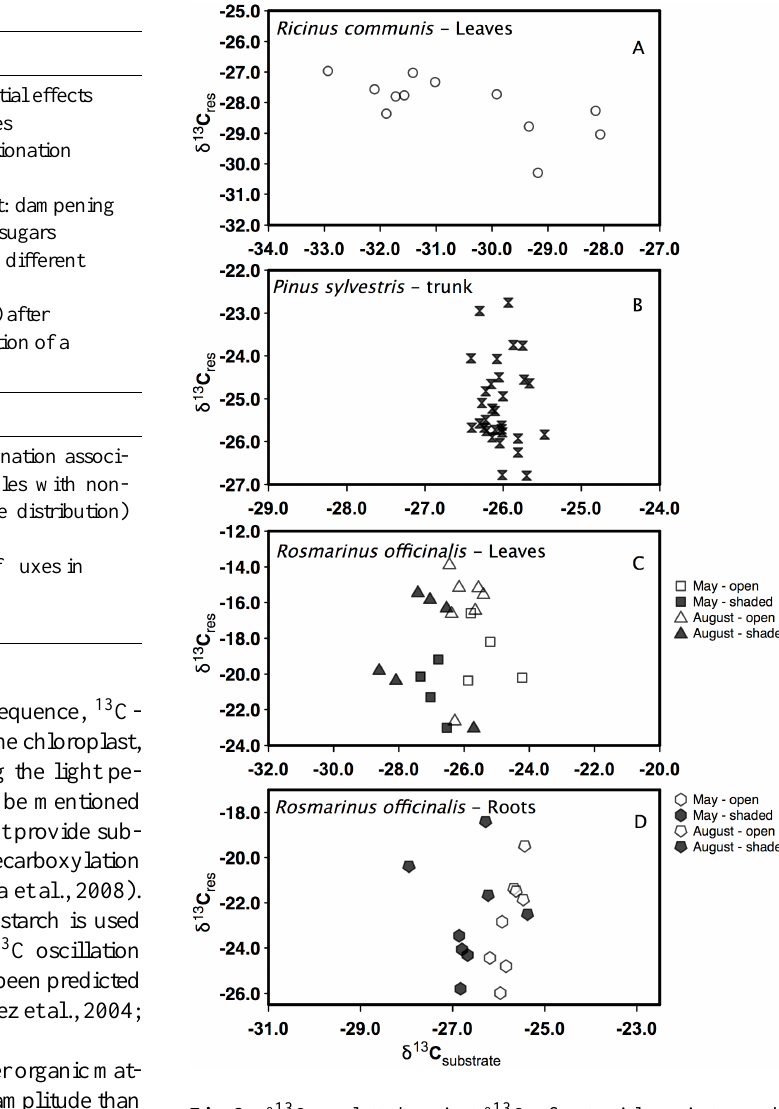
Fig. 3. δ 13 C res plotted against δ 13 C of potential respiratory sub- strates during the diel course. (A) data for leaf emitted CO 2 and leaf soluble sugars in R. communis during a 24h cycle. Each data point represents one individual plant at one time point. Samples were taken twice during the day (10:00; 15:30) and twice during the dark period (22:30; 03:30). Data are from Gessler et al. (2009b). (B) data for trunks of P. sylvestris taken from Kodama et al. (2008). As sub- strate for respiration we have chosen trunk phloem exudates from the same position where the CO 2 measurements were made. Data are from diel courses measured every 3h over 4 days. ( C and D ) data from Rosmariuns officinalis of leaves and roots, respectively; of dark-respired δ 13 C res and WSOM measured every 2–3h over the diurnal course in Portugal in May and August from Dubbert et al.